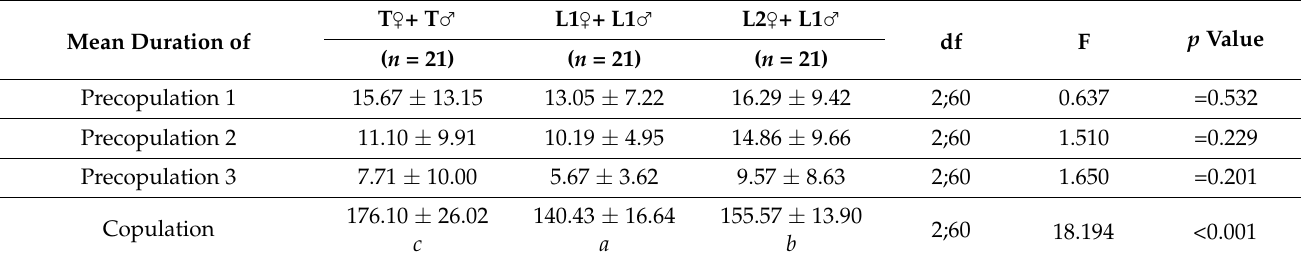
Table 11. The mean duration ( ± SD) of precopulation and copulation